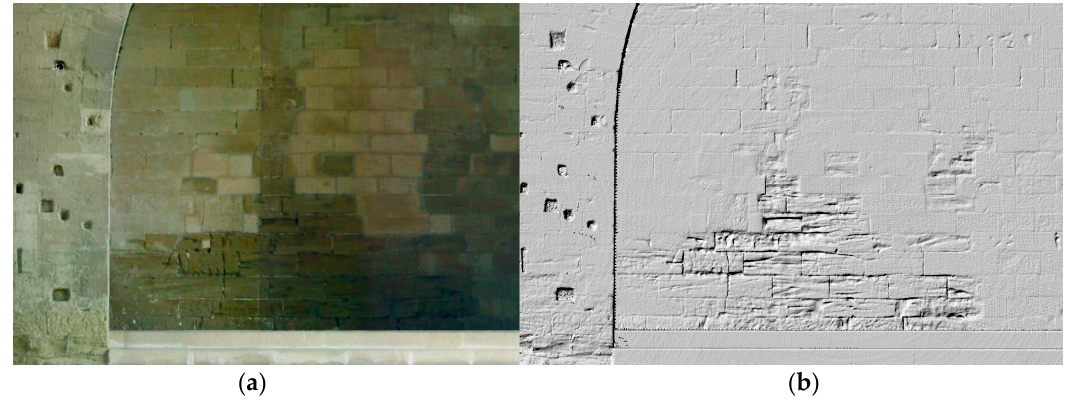
Figure 9. Identification of previous interventions with different stone: ( a ) RGB left; and ( b ) disintegration of stone (hillshade).